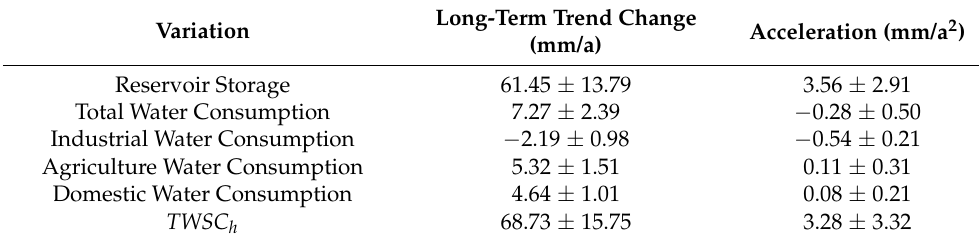
Table 7. The long-term change trend and acceleration of human factors in Sichuan.